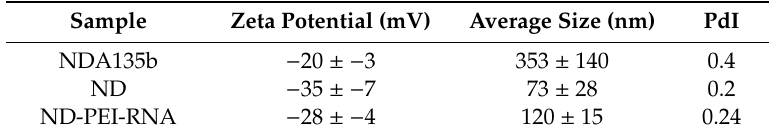
Table 1. Basic characterization of NDA135b complex and its comparison to original nanodiamonds (ND) and similar complex ND-polyethylenimine (PEI)-RNA lacking targeting